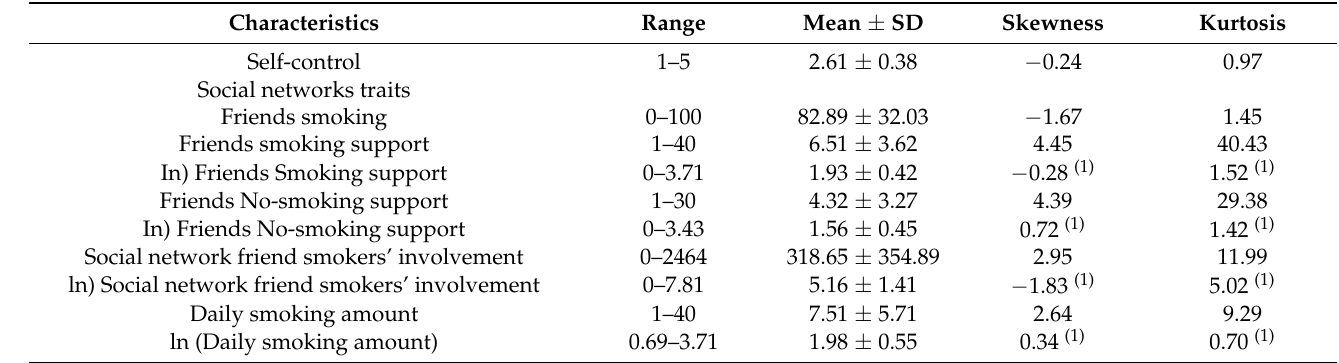
Table 2. Self-control, traits, and actions of friends in social networks, as well as amount of smoking among out-of-school adolescents ( N = 187).